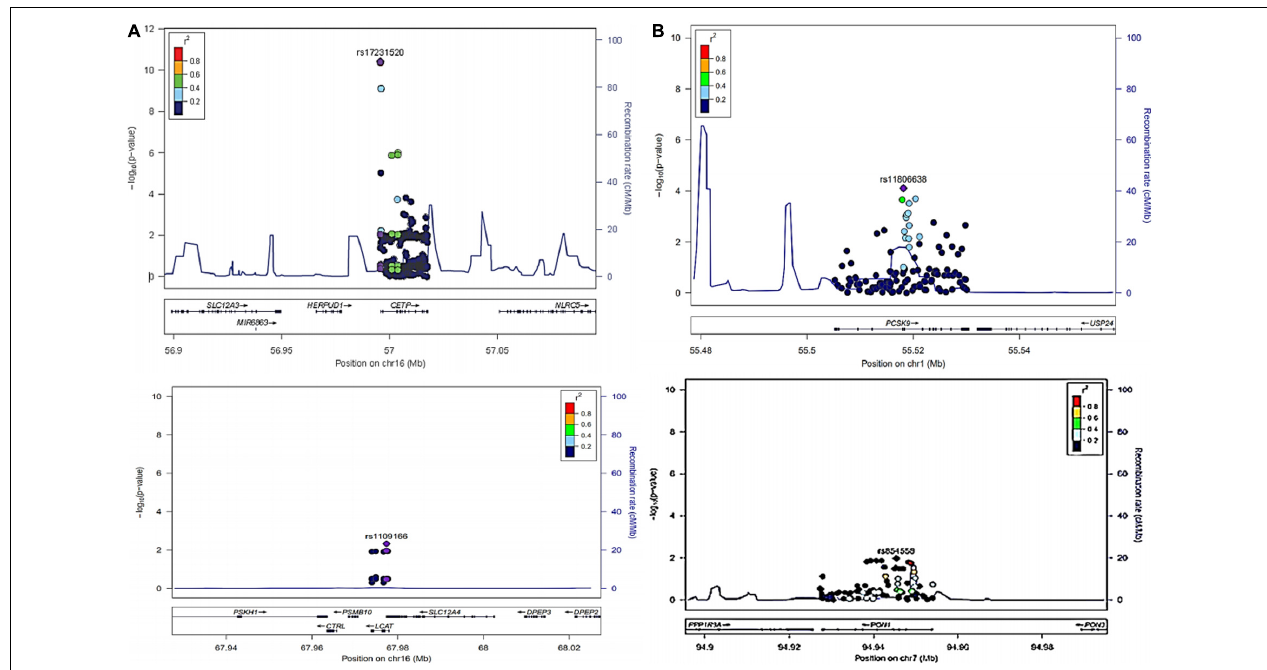
FIGURE 1 | (A) LocusZoom plots of rs17231520 and rs34065661 ( CETP ) and rs1109166( LCAT ) associated with higher and lower levels of HDL-C respectively after adjustment for sex, age and waist circumference. (B) LocusZoom plots of rs11806638( PCSK9 ) and rs854558( PON1 ) associated with lower levels of LDL-C and higher levels of TC respectively after adjustment for sex, age and waist